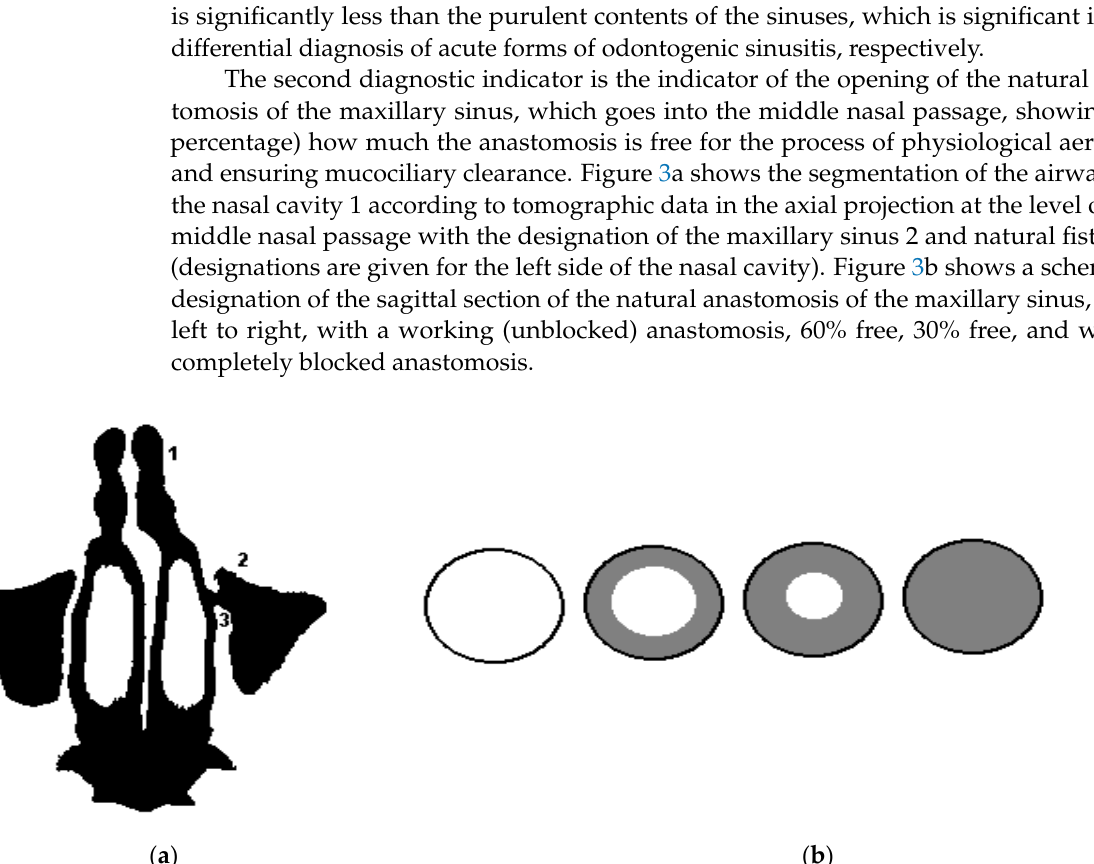
( d ) Figure 4. Schematic illustration of the maxillary sinus in a sagittal projection: ( a ) at a conditional rate, ( b ) at 60% filled sinus cavity with polyposis content; ( c ) when filling the sinus by 40% liquid content; ( d ) filling of the sinus with liquid and polyposis contents by 30% and 20%, respectively. The index of changes in nasal breathing (aerodynamic nasal drag coefficient) can be determined from a set of sections of the air channel of the nasal cavity obtained from tomographic data, an example of which is shown in Figure 5 [38], according to the methodology given in [32,38,39]. The essence of this approach is to calculate the resistance to air flow (during breathing) of the nasal cavity, represented as a channel with a complex configuration [32,38] with the construction of segmented geometric models based on tomographic data [32,38–40].